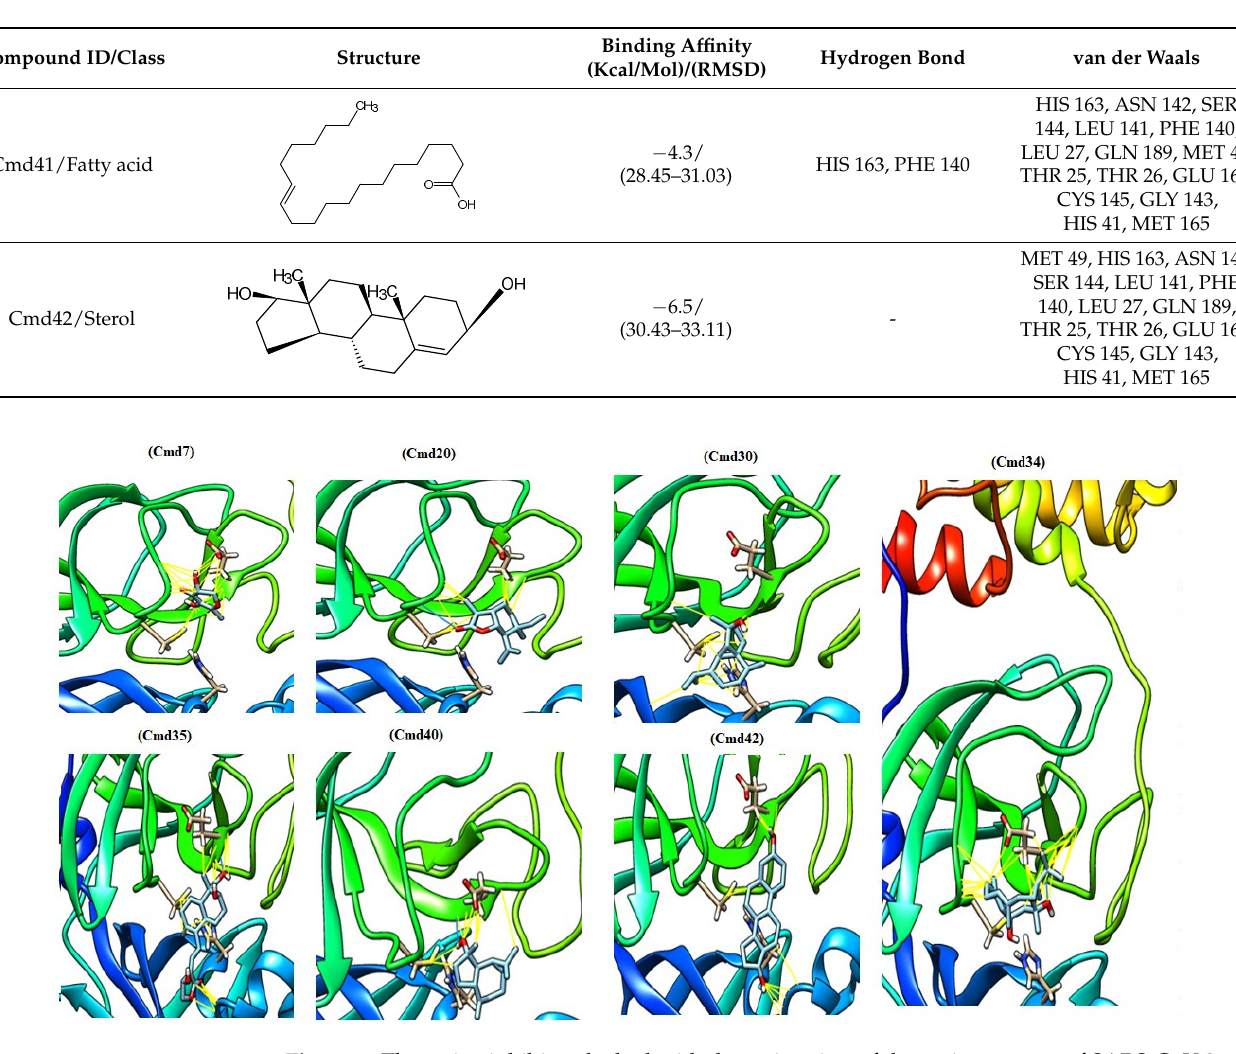
rial activity against a Gram-positive bacterium ( Bacillus subtilis ) and a Gram-negative bac- terium ( Escherichia coli ); however, these results showed higher activity with the non-polar extract (Chloroform extract) [69], indicating that the bioactive phytochemical molecules were not attracted by the aqueous extract and that the bioactive compounds might have a non-polar or a hydrophobic nature.